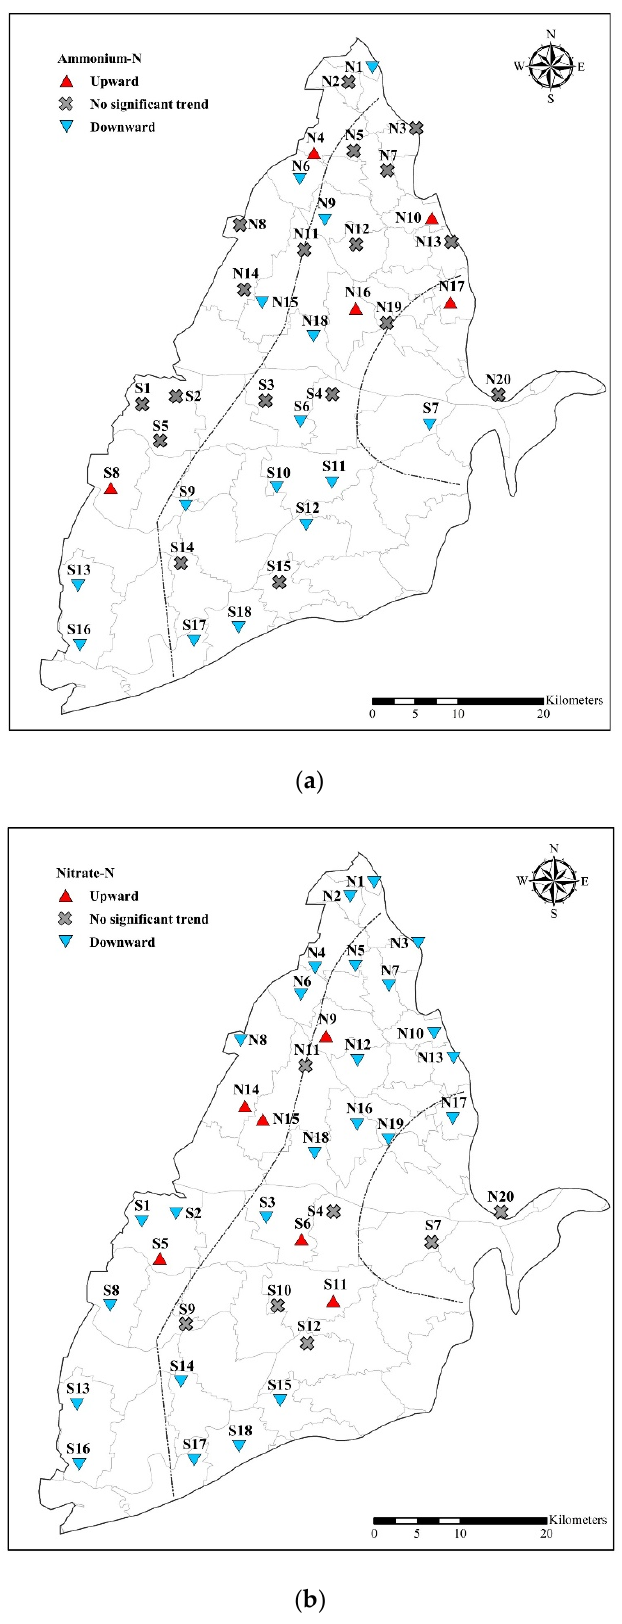
Figure 5. Spatial distribution of entire-period Mann–Kendall (MK) trends of ( a ) ammonium–N and ( b ) nitrate–N concentrations for each monitoring well in the study area.